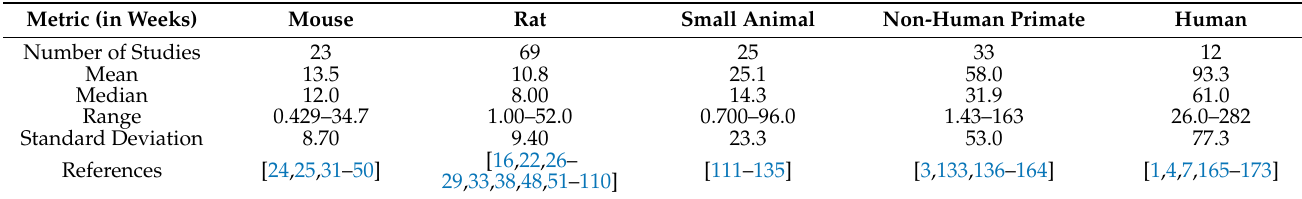
Figure 1. Chronic durations based on animal species. The box is determined by the 25th and 75th percentiles while the whiskers indicate 1.5 times the interquartile range. The minimum and maximum are represented by asterisks while the horizontal line and small square within the box indicate the median and mean, respectively. The numbers below each box and whisker plot reflect the number of studies contributing to the plot. Table 1. Chronic time point statistics based on model.